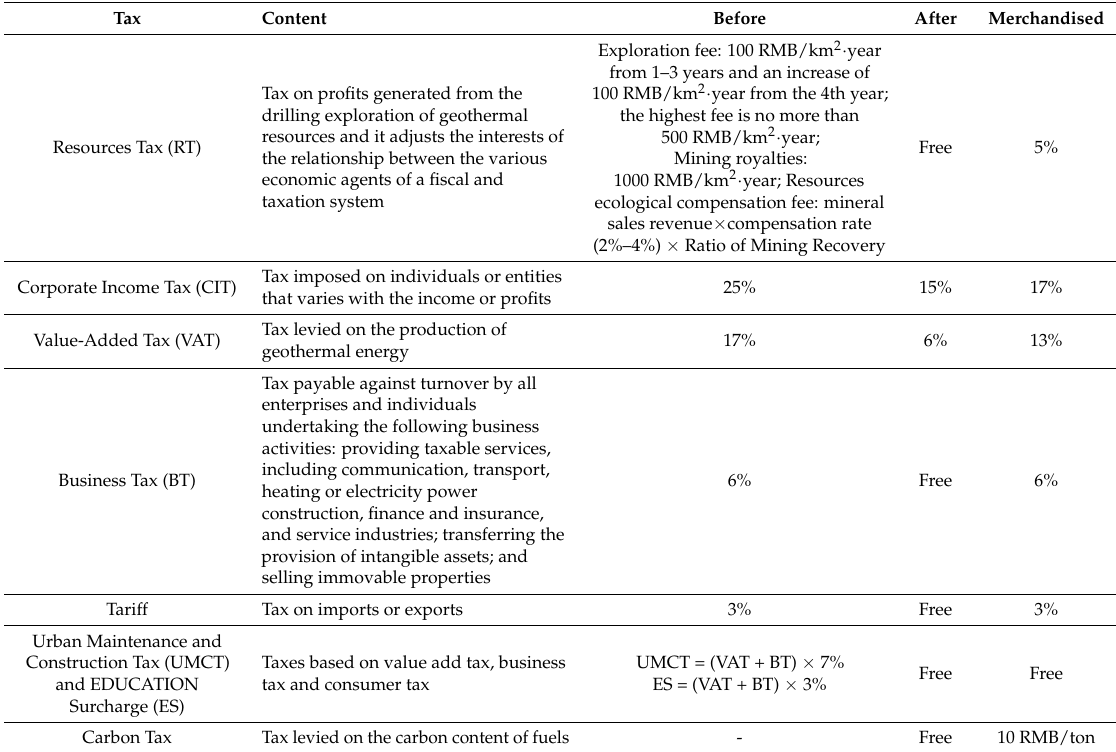
Table 9. Comparison of taxes in the geothermal